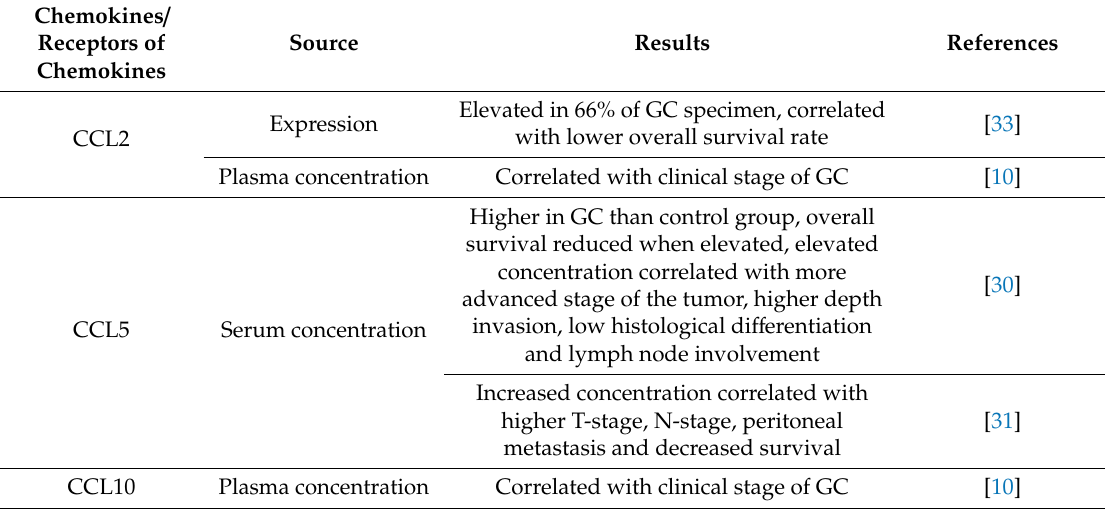
Table 2. The role of CCL chemokines in gastric cancer